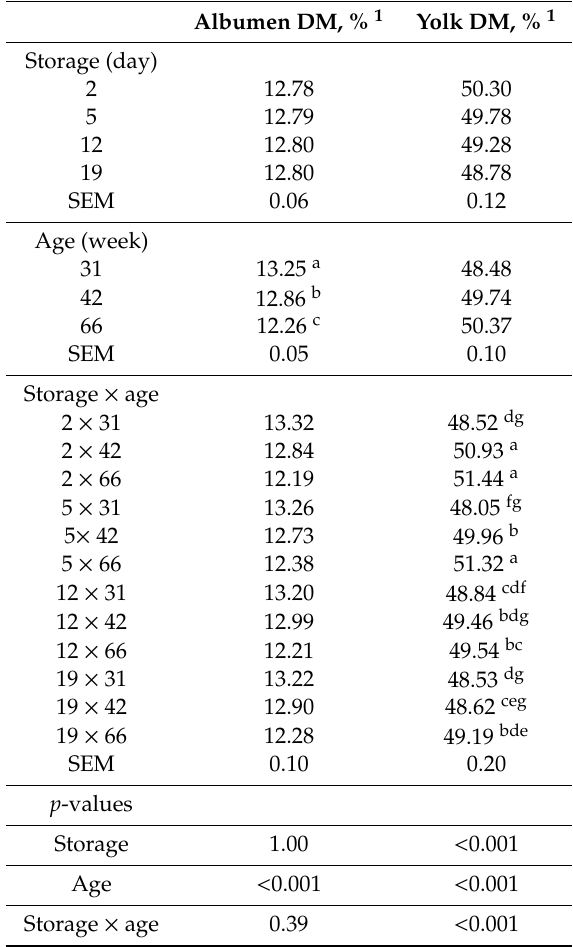
Table 2. E ff ects of egg storage duration and broiler breeder age and their interaction on albumen